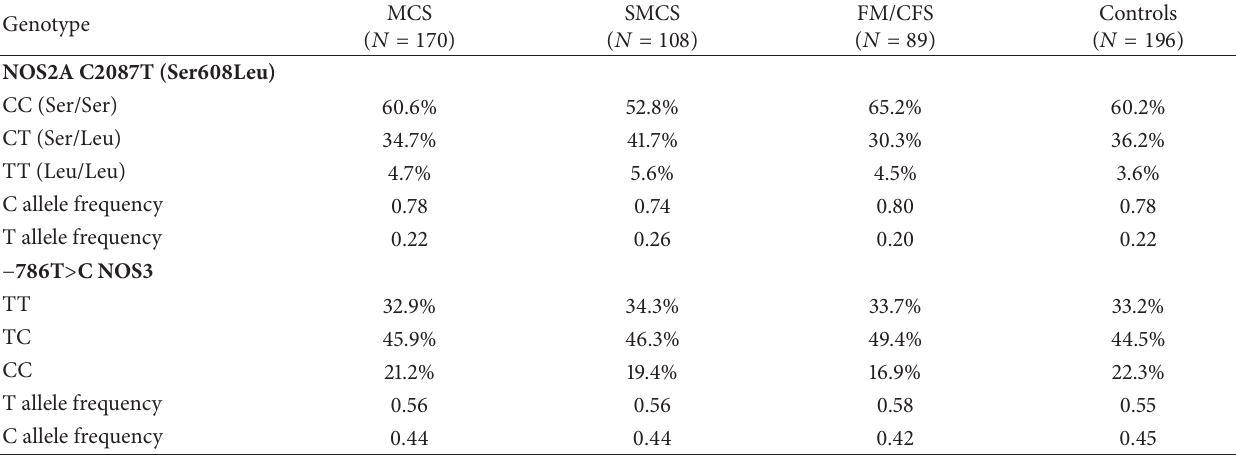
Table 1: Allele and genotype frequencies of NOS2A and NOS3 SNPs in IEI patients and healthy subjects.